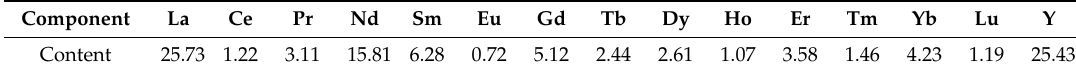
Table 2. Rare earth partition of the rare earth ore.